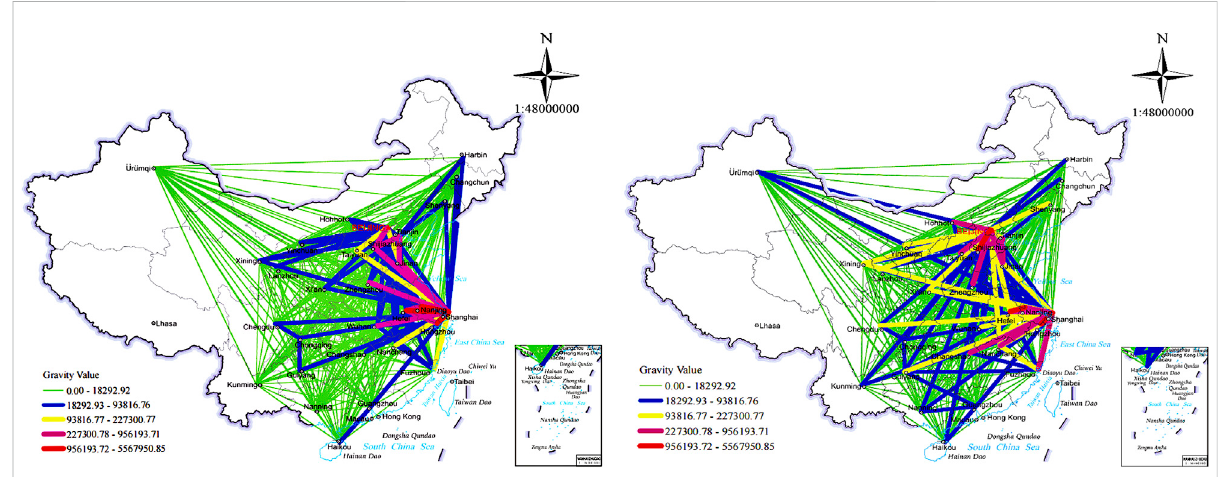
FIGURE 2 Spatial correlation intensity of ALTFP in China in 2020. Note: The map is made based on the standard map downloaded from the standard map service website of the National Bureau of Surveying, Mapping and Geographic Information, with the review number GS (2019) 1,673 and no modi fi cation of the base map (https://service.tianditu.gov.cn/#/).